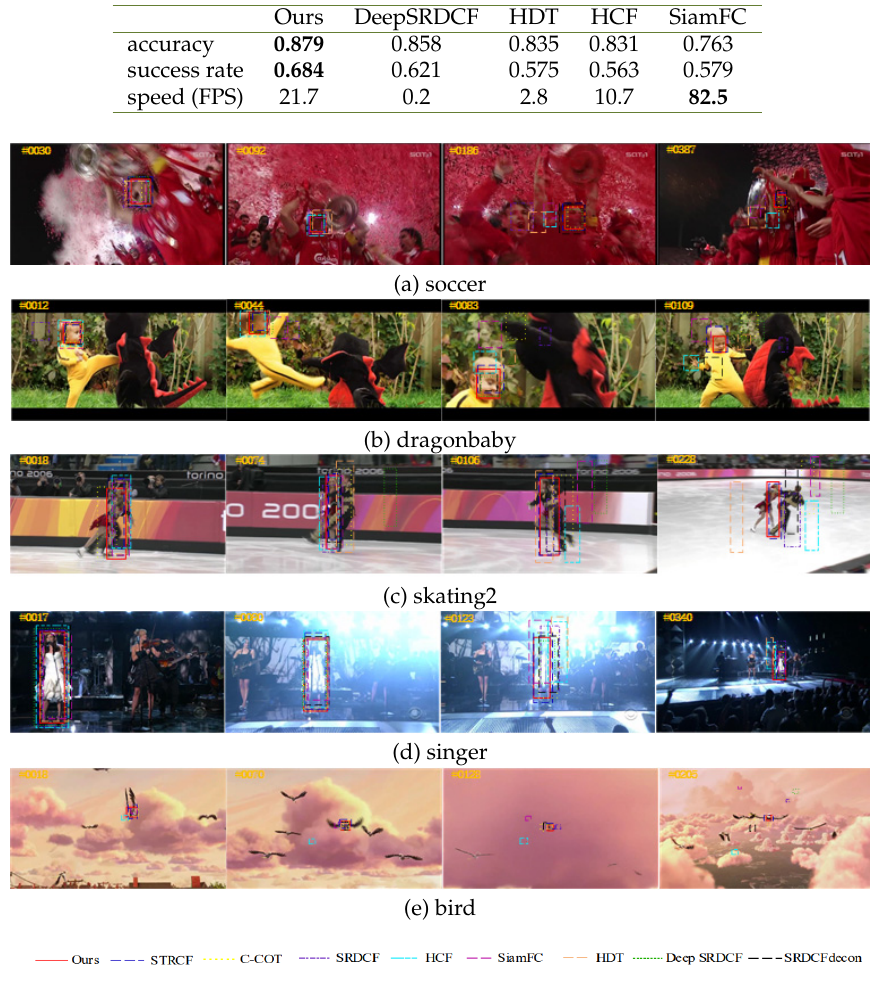
Table 2. Performance comparison of tracking methods based on deep learning